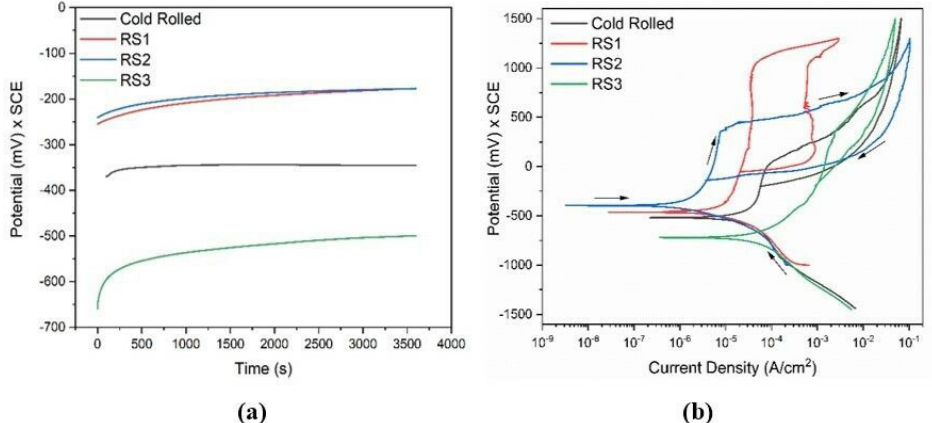
Figure 10. (a) Open circuit potential; (b) Cyclic potentiodynamic polarization. The arrows indicate the direction of polarization. Table 4. Electrochemical parameters obtained in a 3.5 wt% sodium chloride solution for the 316L stainless steel under the cold rolled and rapid solidification conditions in regions RS1, RS2 and RS3.